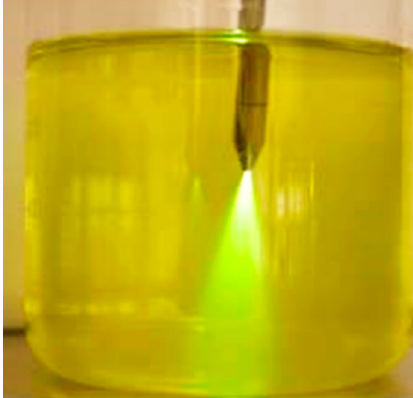
Figure 5. Cannula sterican 19G, 30° bevel [4].